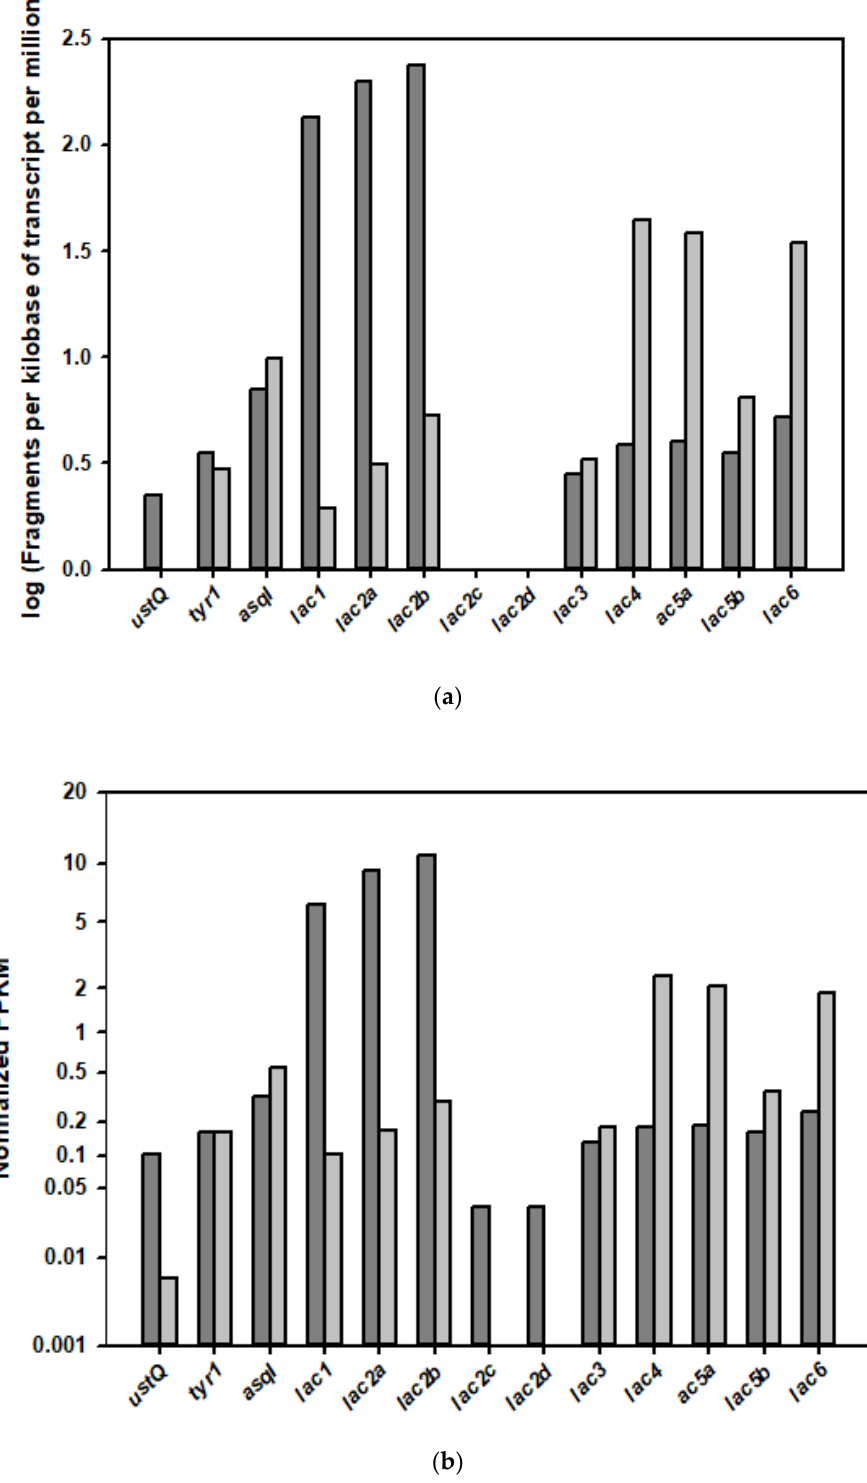
Figure 5. Transcription levels of tyrosinase- and laccase-coding genes involved in the enzymatic browning reaction in the fruiting body (dark gray) and the mycelium (gray-white) of H. erinaceus . ( a ) Log scale for transcription levels expressed as fragments per kilobase of transcript per million (FPKM). The log (FPKM) values of lac2c and lac2d were less than −0.1. ( b ) Normalized FPKM values relative to a suite of endogenous actin genes in each growth phase.